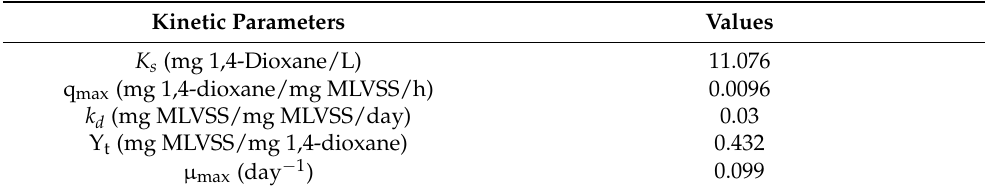
Table 2. Summary of kinetic parameter evaluation by batch testing of 1,4-dioxane biodegradation. Kinetic Parameters